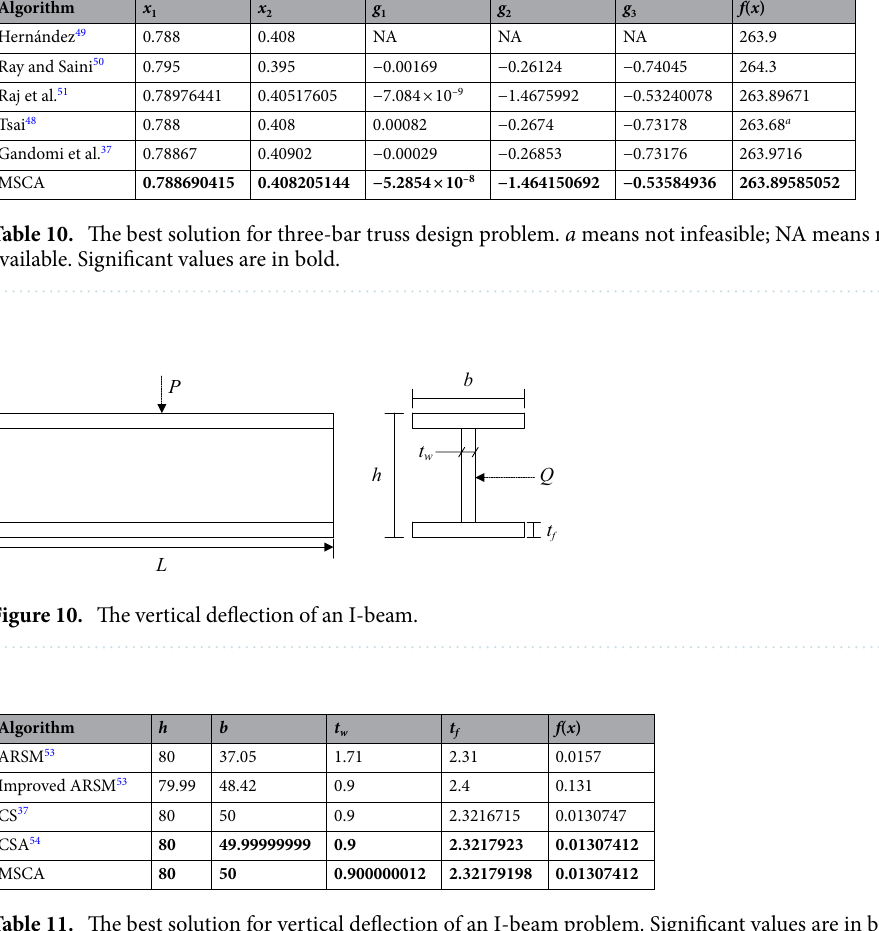
Table 11. The best solution for vertical deflection of an I-beam problem. Significant values are in bold.